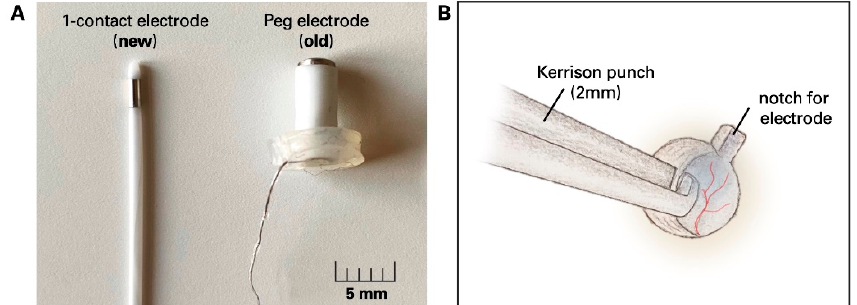
Figure 4. Comparison of epidural 1-CE and Peg electrodes. ( A ) Photograph of the recently imple-